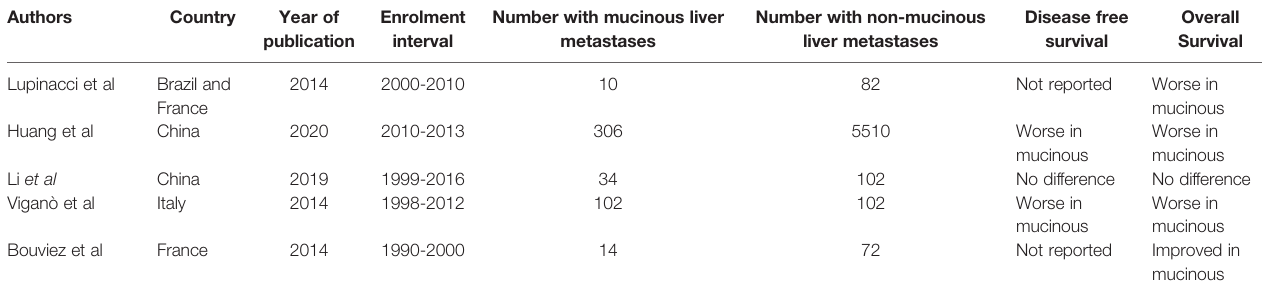
TABLE 3 | Results of previously published papers comparing mucinous liver metastases to adenocarcinoma NOS liver